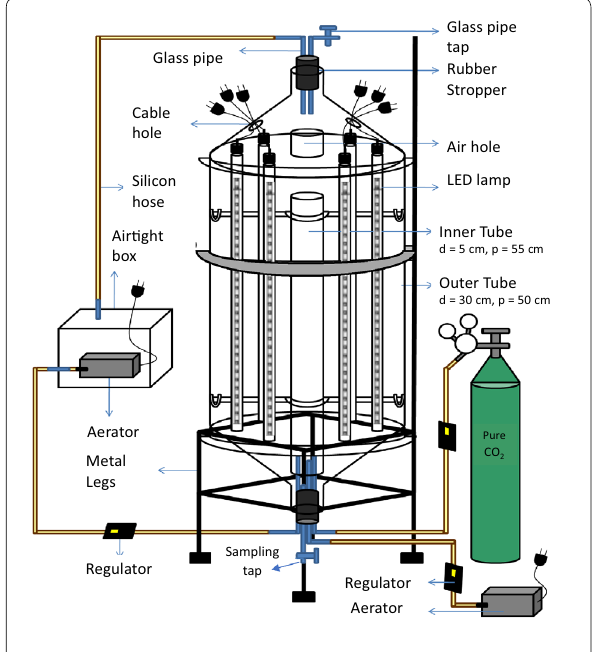
Fig. 1 Airlift photobioreactor design with six series of blue LED lamps and pure CO 2